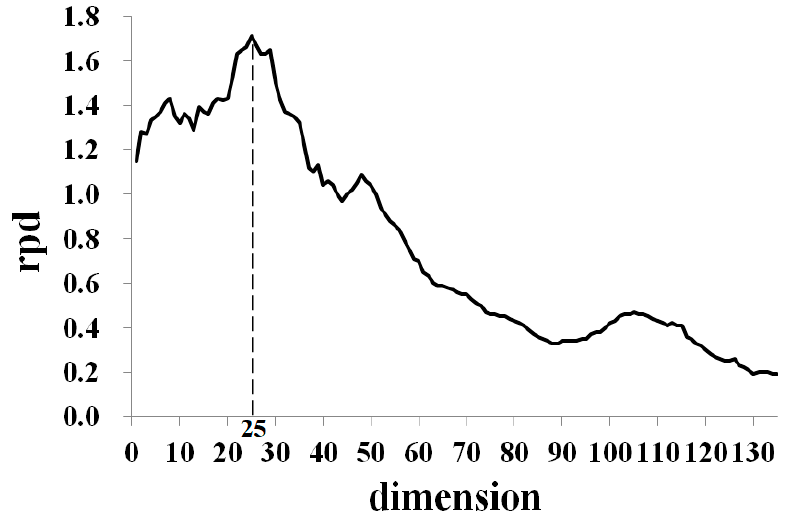
Figure 4. Model accuracy for different dimensions during dimensionality reduction.